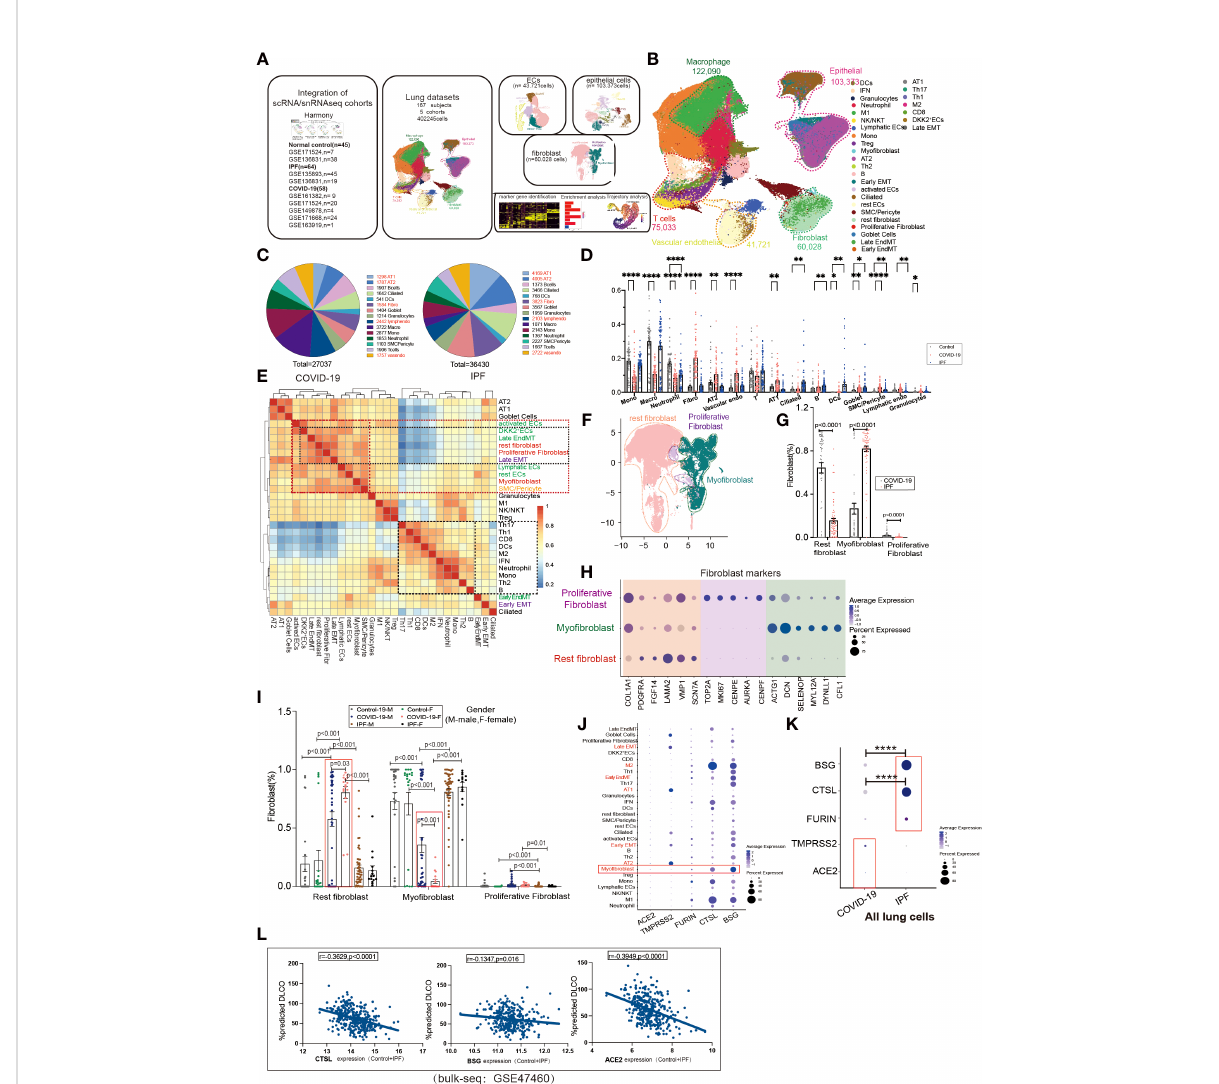
FIGURE 1 Subpopulation correlation analysis suggested a strong correlation between MT subpopulation and fi broblast subpopulation. (A) Scheme of this study. (B) Demonstration of HC, COVID-19, and IPF subgroups using UMAP, including Endothelial (vascular endothelial: rest ECs, EndMT, DKK2+ ECs, activated ECs; Lymphatic ECs); Epithelial (AT2, AT1, Goblet Cell, EMT, Ciliated); Fibroblast (Proliferative Fibroblast, Myo fi broblast, Rest fi broblast, Late EndMT, Late EMT); SMC/Pericyte; T cells (Th1, Th17, Th2, Treg, NK/NKT, CD8, IFN); Macrophage (M2, M1); Granulocytes; DCs; Mono; Neutrophil. And the proportion of cell subpopulations in HC, COVID-19, IPF. Marker genes: Endothelial cells:PECAM1, VWF, CLDN5; Macrophages: MARCO, MSR1, MRC1;T cells:CD3E, CD3D, GZMH; Granulocytes:MS4A2, CPA3, TPSAB1; B cells:MS4A1,